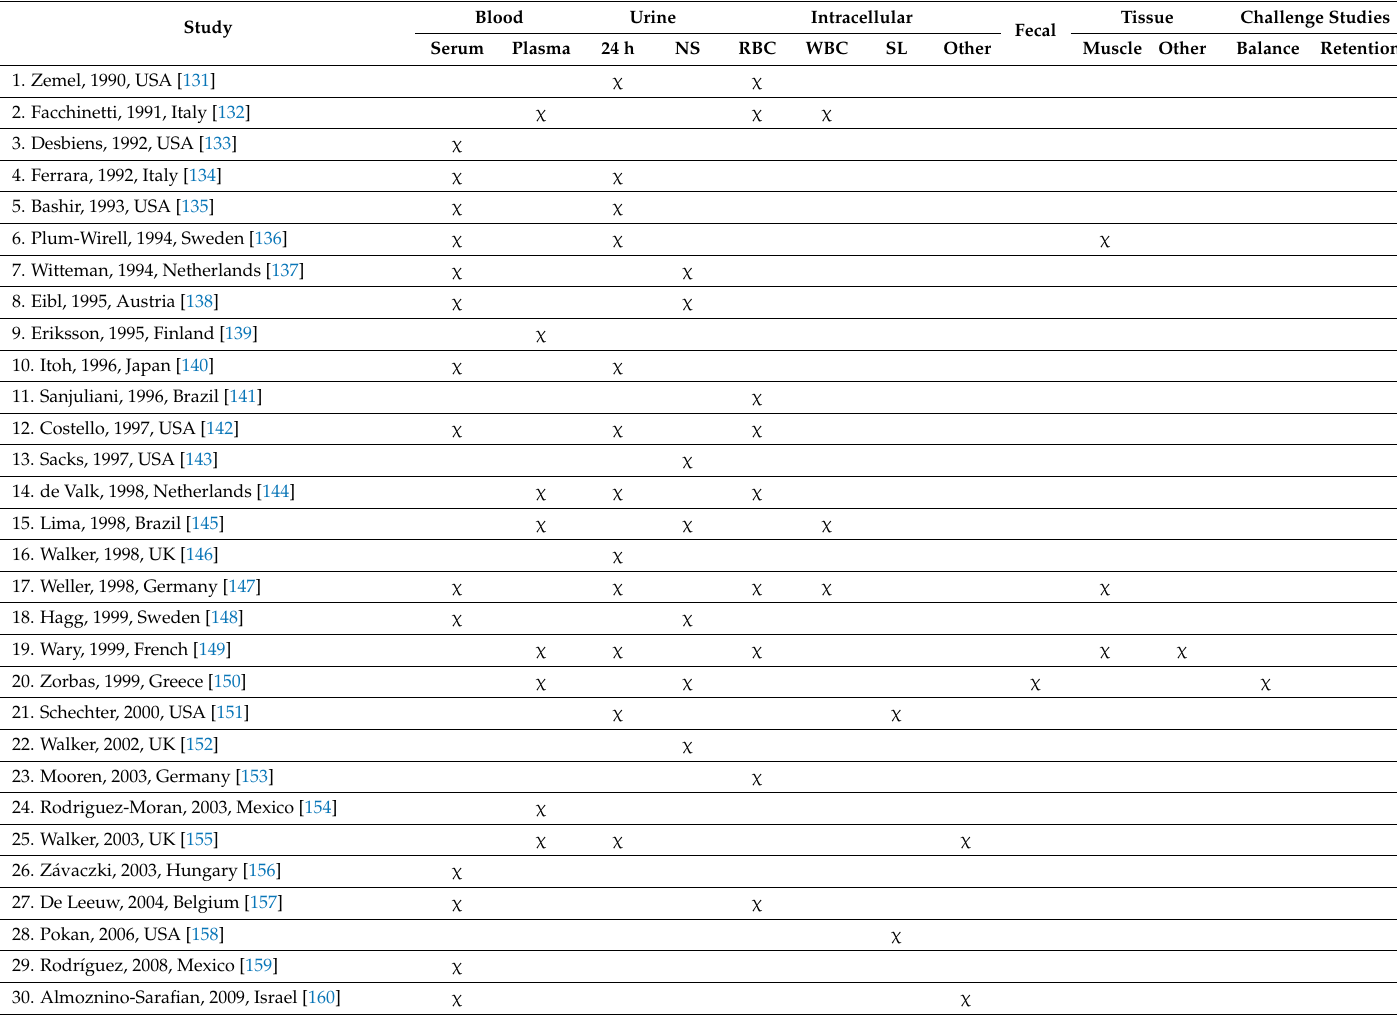
Table 1. Magnesium clinical trial studies by year with method of determining magnesium status indicated. Expanded from Zhang et al. [130].